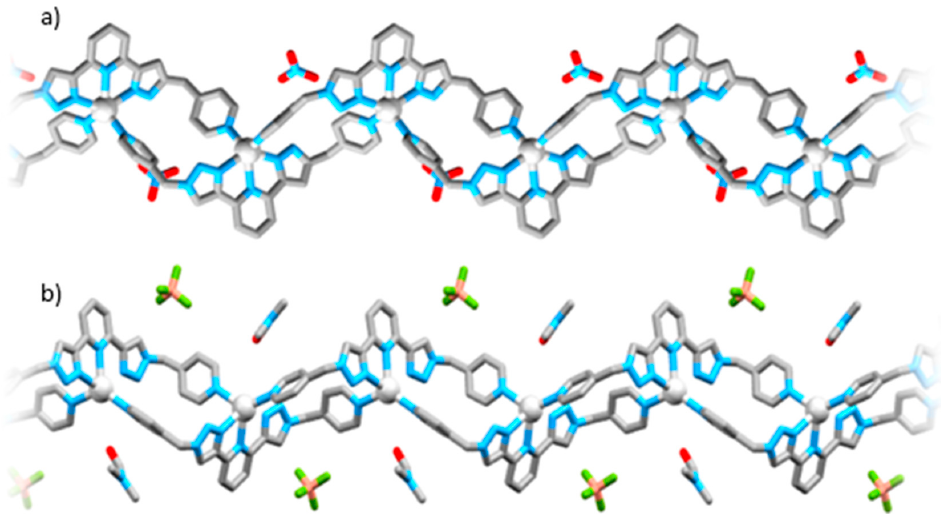
Figure 4. Solid state structures of ( a ) [Ag( L )]NO 3 and ( b ) [Ag( L )]BF 4 . Selected bond lengths (Å): [Ag( L )]NO 3 Ag1-N1 = 2.298, Ag1-N9 = 2.315, Ag1-N4 = 2.493, Ag1-N5 = 2.397, Ag1-N6 = 2.480; [Ag( L )]BF 4 Ag1-N5 = 2.451, Ag1-N9 = 2.331, Ag1-N1 = 2.250, Ag1-N6 = 2.725, Ag1-N4 = 2.500. Color scheme: carbon, grey; nitrogen, blue; silver, silver; boron, salmon; fluorine, green; oxygen, red. Hydrogen atoms were omitted for clarity.